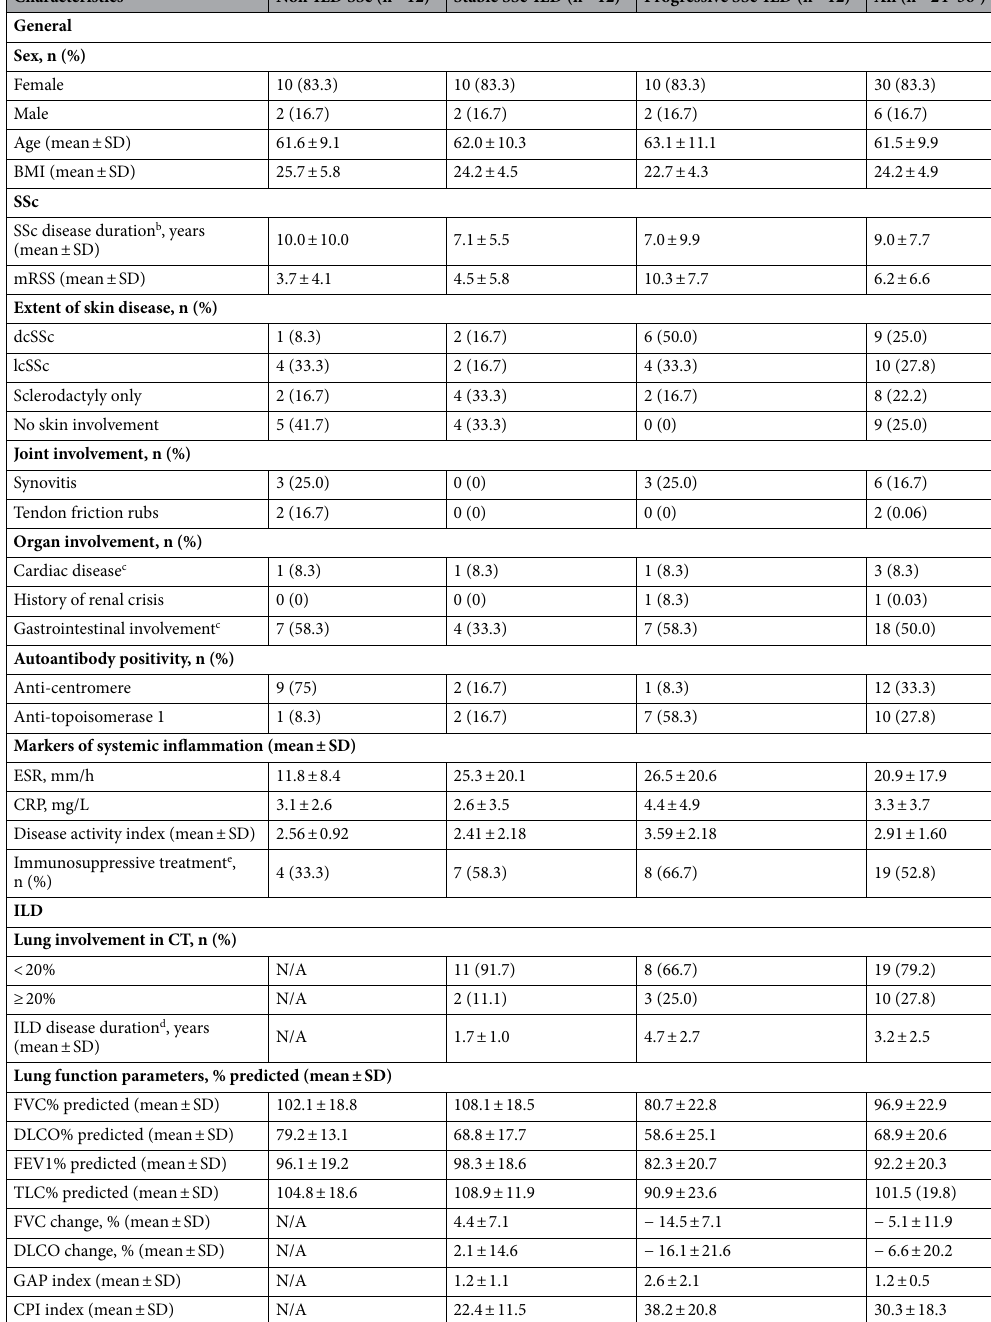
Table 1. Clinical characteristics of SSc patients of the Zurich cohort at time point of serum collection. BMI body mass index, CPI composite physiologic index, CRP C-reactive protein, dcSS diffuse cutaneous SSc,